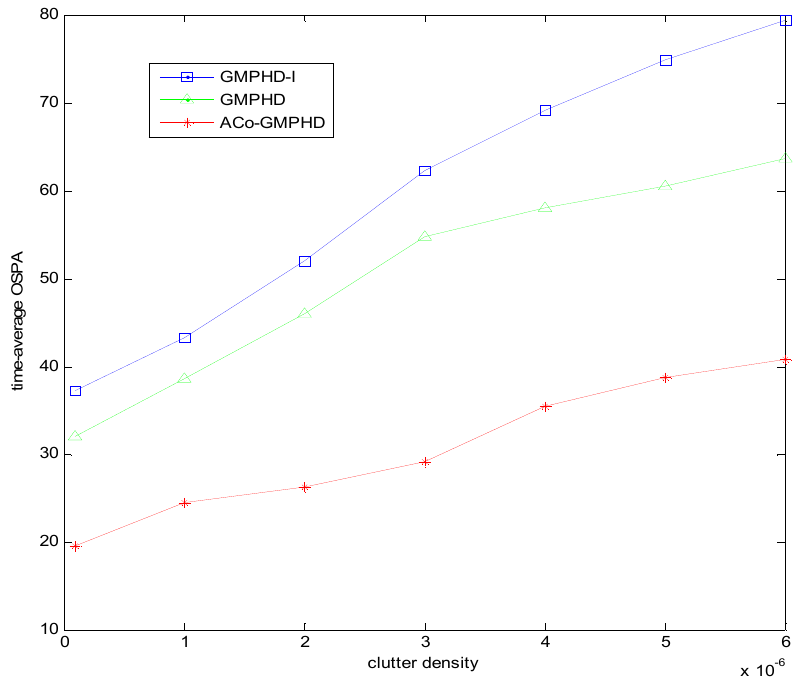
Figure 6. Time-averaged OSPA distance in one run of each filter for varying clutter densities.